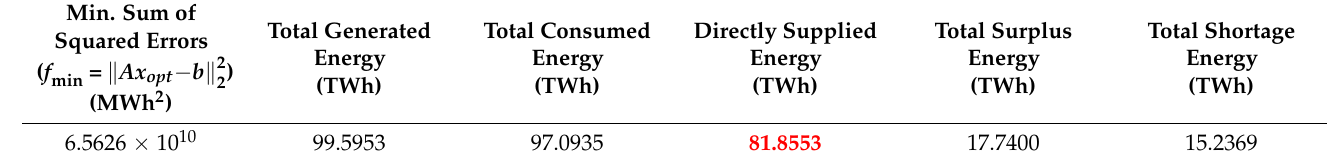
Table 3. Characteristics of the consumption covering for the optimized structure and spatial allocation of RES (for the analyzed three-year referent time period). The directly supplied energy is marked red as it is the main